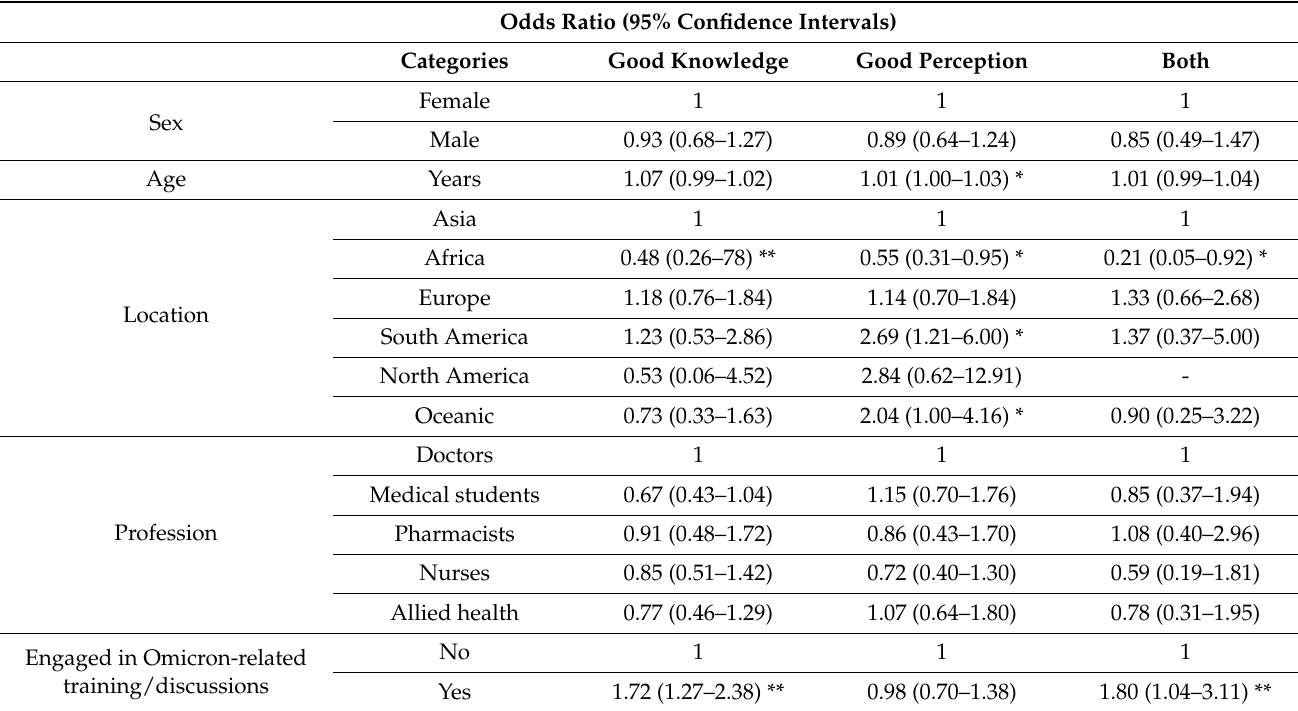
Table 5. Factors associated with good knowledge and perception about the SARS-CoV-2 Omicron. Odds Ratio (95% Confidence